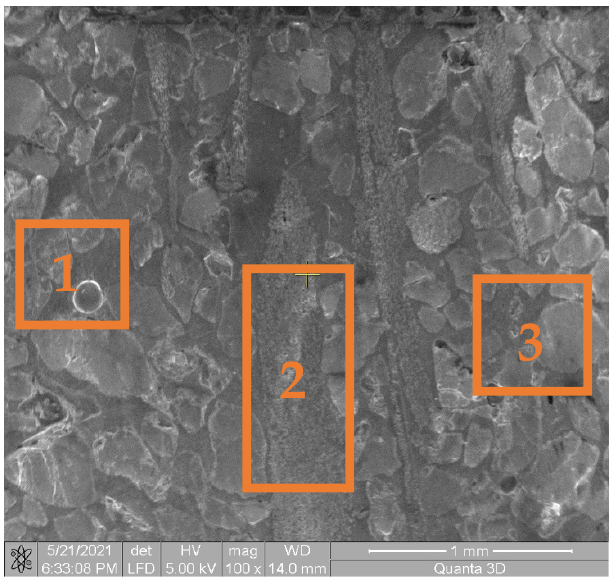
Figure 8. SEM images for different areas used for EDS chemical analysis. (1) SEM images for General aspect area, (2) SEM images for Continous Fibres area, (3) SEM images for Particles area.